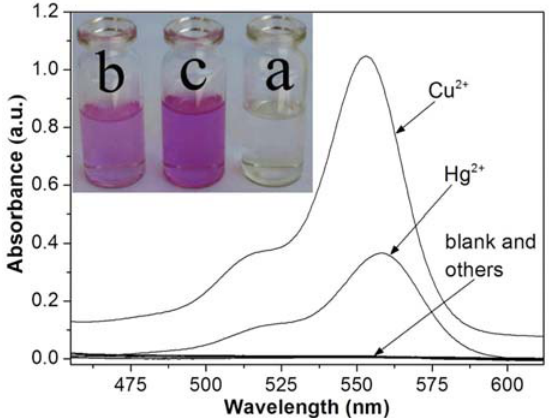
Figure 4. UV-vis spectra of RD (10 μM) upon addition of various cations (10 μM) in MeCN-H O buffer solution. Inset: Colors of RD 2 solution before (a) and after the addition of Hg 2+ (b) or Cu 2+ (c) un- der natural light.